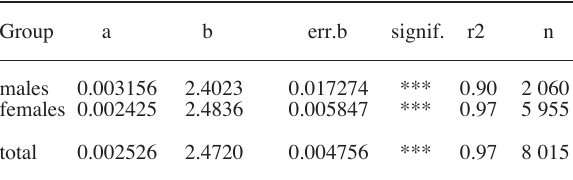
T ABLE 2. – Parameters of relative growth (size-weight relationship: Weight = a * Size b ) calculated for males and females of Aristeus antennatus . Level of significance ***= p<0.001, **= p<0.01, *= p<0.05 and NS= p<0.1 in the Student “t” test.